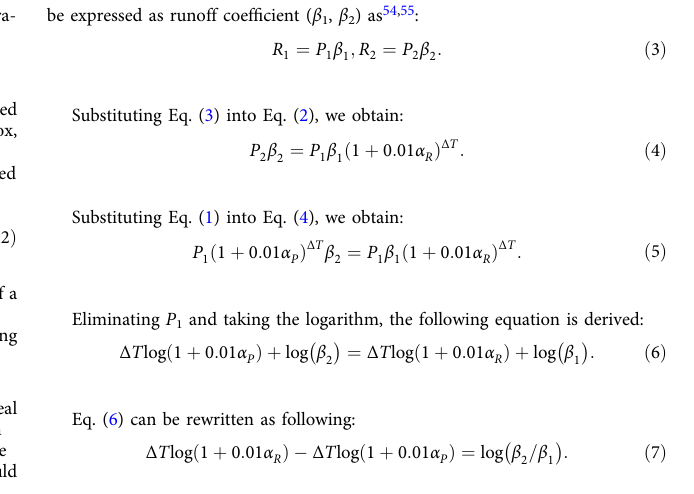
where α R is the scaling rate at which runoff extreme change with temperature. If a hook-like structure was observed in the relationship between precipitation – temperature scaling or runoff-temperature scaling, regression fi tting is applied only up to the peak ‐ point temperature 47 – 49 . Comparing scaling rates of runoff and precipitation extremes . Our fi nds reveal a higher scaling rate of runoff than precipitation with temperature. To assist in explaining these results, we partially attribute the different responses of extreme events to local surface temperature by runoff coef fi cient change. The runoff could